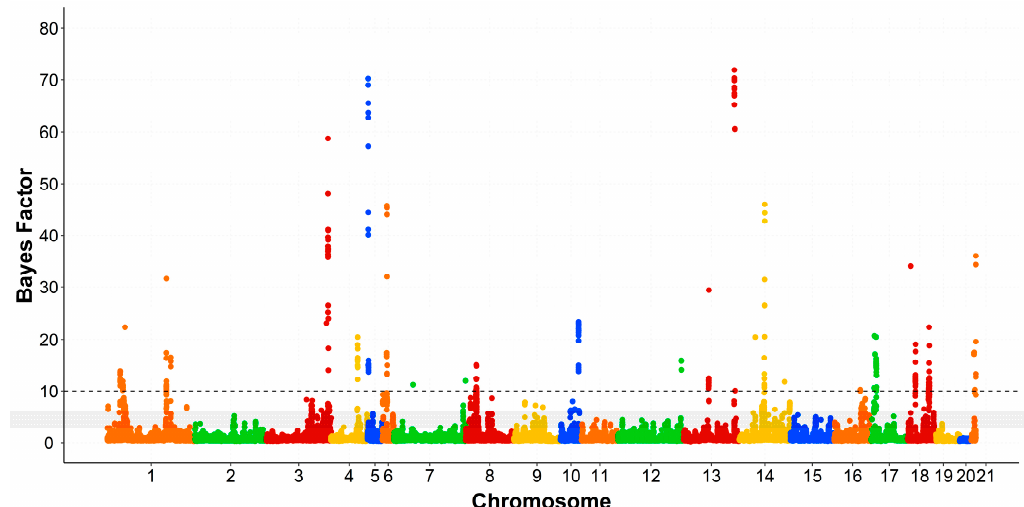
Figure 3. Manhattan plot of genome-wide association study for monounsaturated fatty acids. The black dashed line indicates the Bayes factor threshold of 10. Each dot represents a SNP. X-axis: chromosomes. Y-axis: Bayes factor.